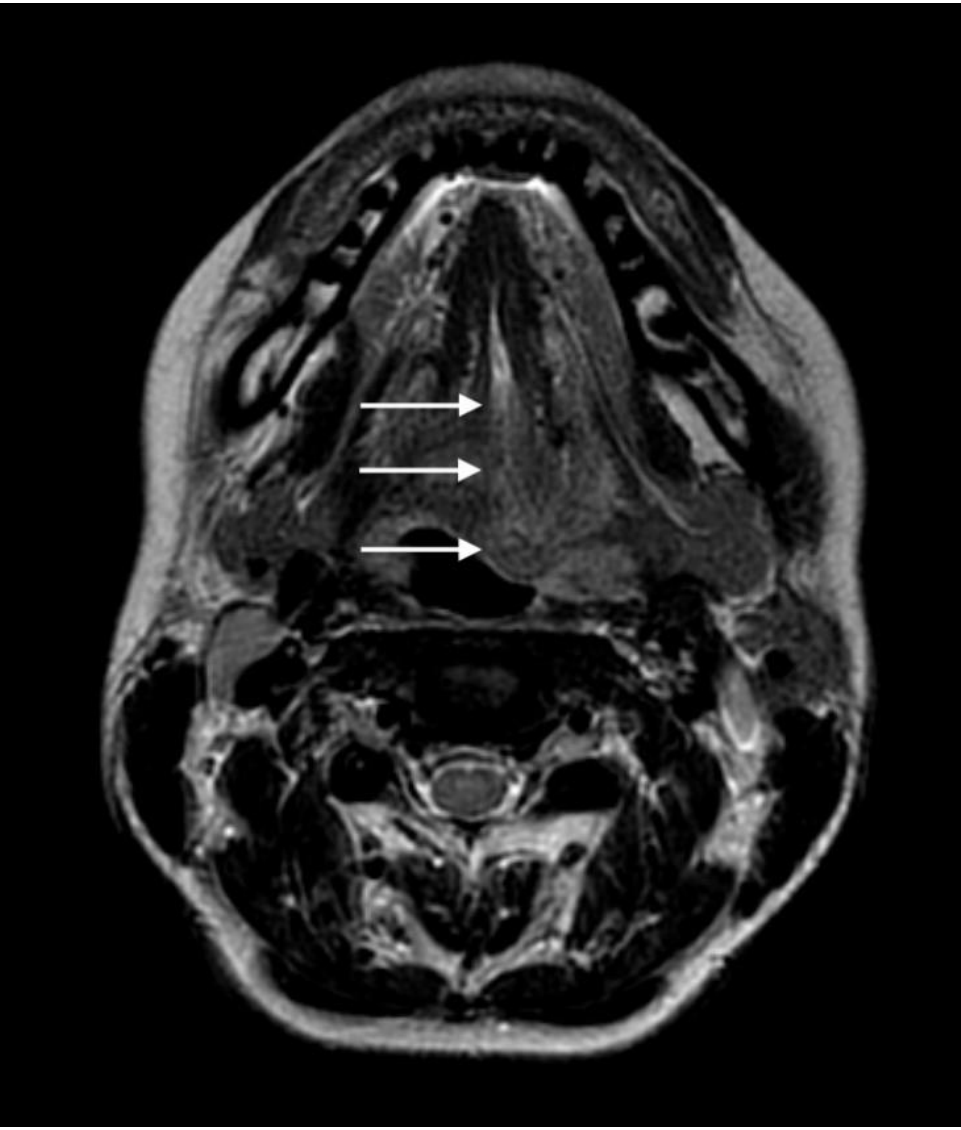
Figure 3. Axial T2-weighted image acquired during the baseline MRA of the head arteries. Axial T2-weighted image shows a swollen left hemitongue and increased T2 signal secondary to oedema (arrows).